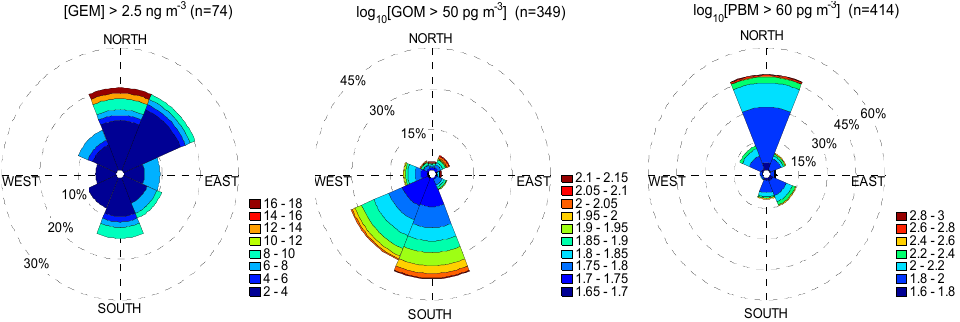
Figure 11. Relationships between wind direction and GEM ( left ) and between wind direction and GOM ( middle ) or PBM ( right ). Individual data points are hourly averaged measurements.